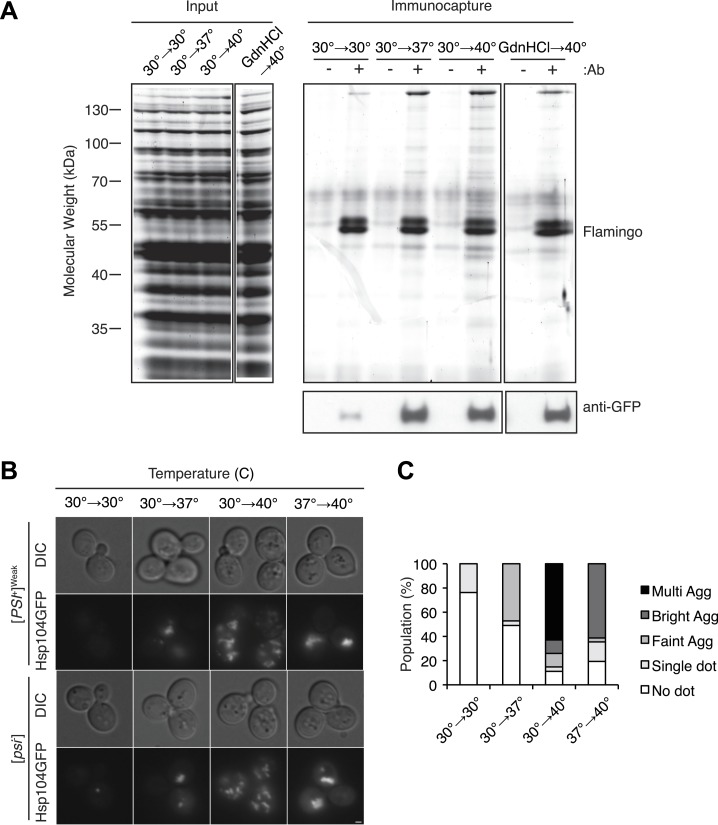
Hsp104 engages heat-induced substrates upon thermal stress.(A) A [PSI+]Weak strain with a GFP-tagged endogenous Hsp104 (SY2126) was incubated at 30°C, 37°C, 40°C, or 40°C with GdnHCl for 30 min, and immunocapture in the presence (+) or absence (−) of anti-GFP antibodies (Ab) was performed on native lysates. Proteins were analyzed by SDS-PAGE and general protein staining (Flamingo, top), or immunoblotting for GFP (bottom). (B) [PSI+]Weak (SY2126) or [psi−] (SY2125) HSP104GFP strains were incubated at 30°C, 37°C, 40°C, or 37°C before 40°C for 90 min, and the pattern of Hsp104-GFP fluorescence was examined by microscopy. Scale bar = 1 μm. (C) Quantification of Hsp104-GFP fluorescence pattern in [PSI+]Weak (SY2126) cells, treated as described in (B): no localization (white); single dot (light gray); faint aggregate (medium gray); bright aggregate (dark gray); multiple bright aggregates (black); n > 25.